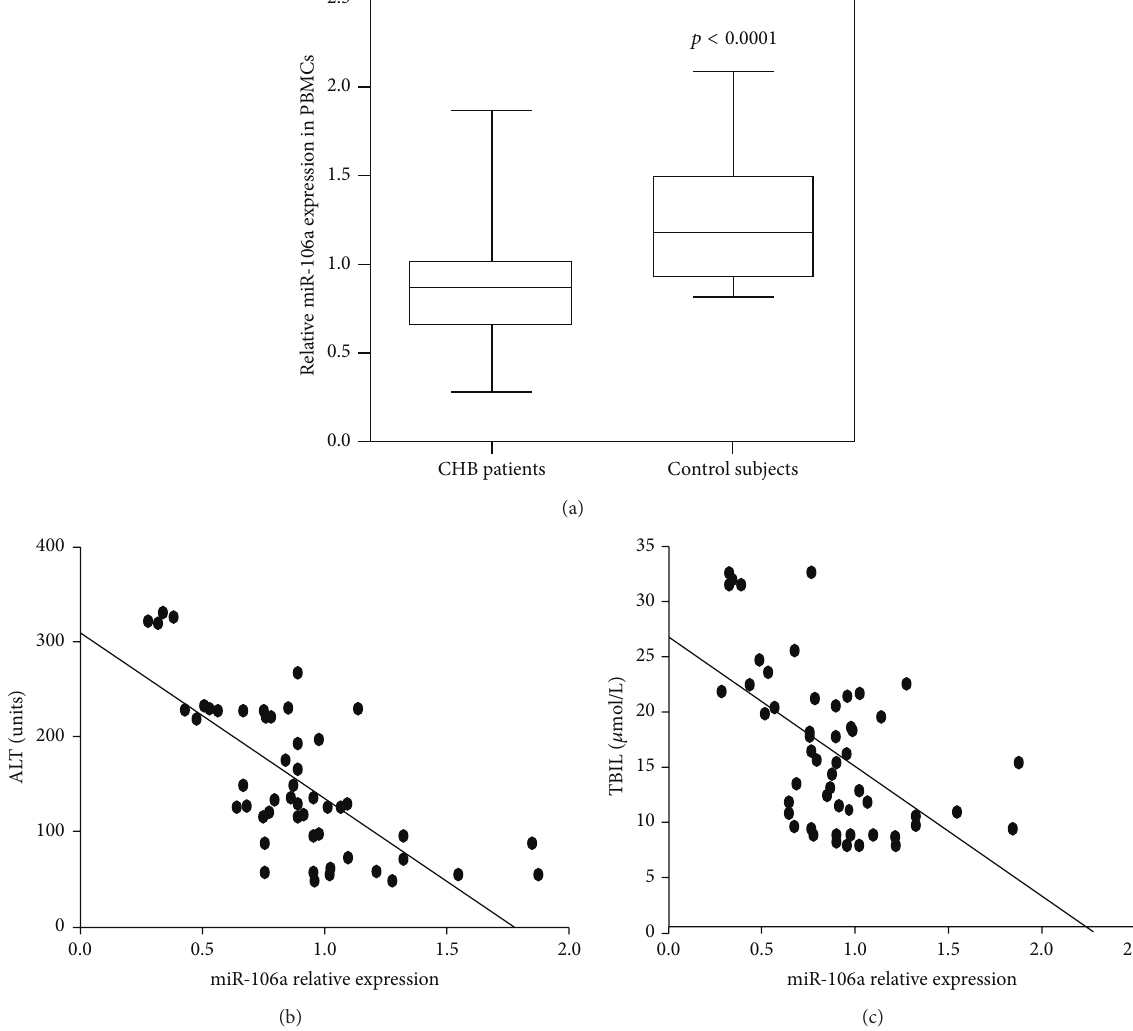
Figure1:miR-106aisdownregulatedinPBMCsofCHBpatientsandisnegativelycorrelatedwithserumalanineaminotransferase(ALT)level. (a) The expression levels of miR-106a in PBMCs of 56 CHB patients and 40 healthy controls were determined by qRT-PCR. The expression levels were normalized to U6B. (b) PBMC miR-106a was negatively correlated with serum ALT levels. (c) PBMC miR-106a was negatively correlated with TBIL